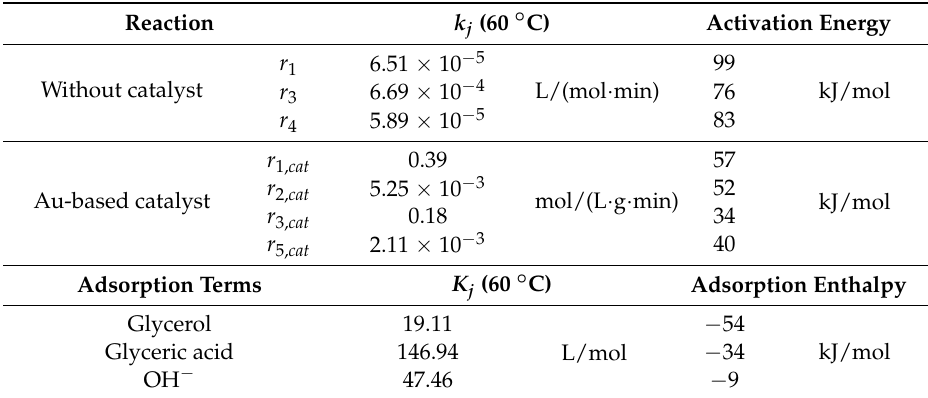
Table 3. Arrhenius and Van’t Hoff parameters of all estimated reactions and